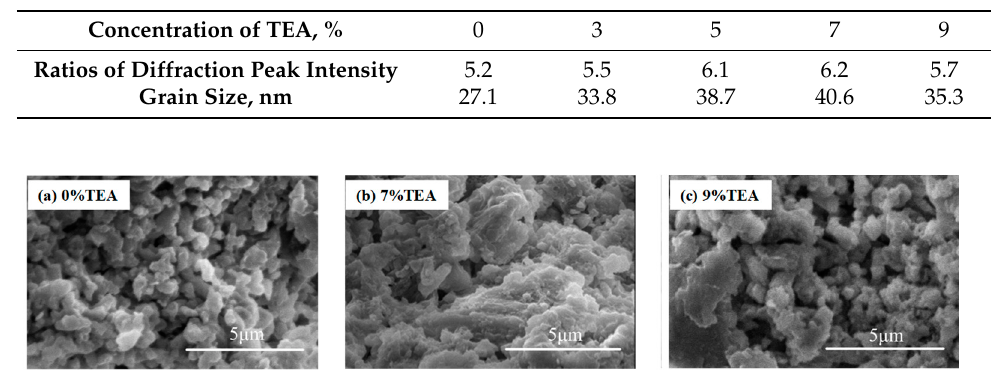
Figure 3. SEM of carbonated matrix with 0% TEA ( a ), 7%TEA ( b ) and 9%TEA ( c ).